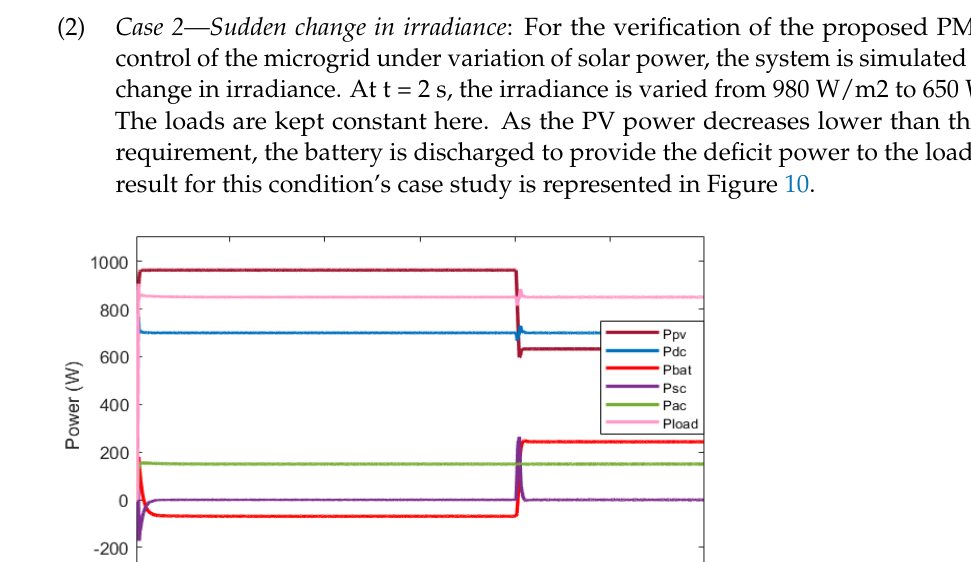
Figure 9. ( a ) PV, DC load, AC load, supercapacitor, and battery power for load variation; ( b ) battery SOC. SOC .